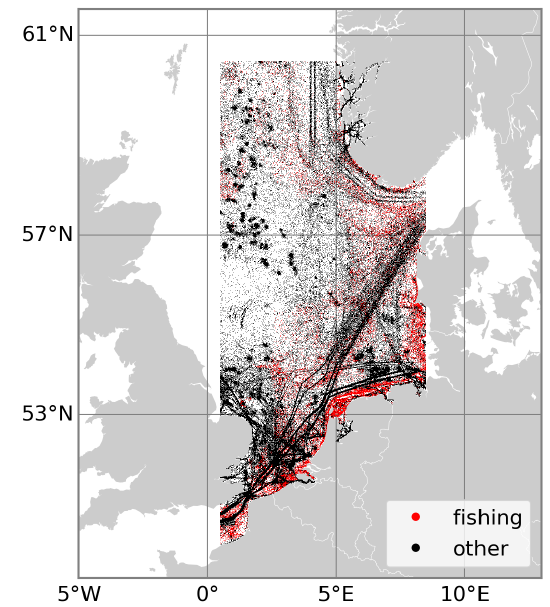
Figure 10. Classification of the Sentinel-1 dataset (144,744 fishing vessels and 723,493 non-fishing vessels in 2017).